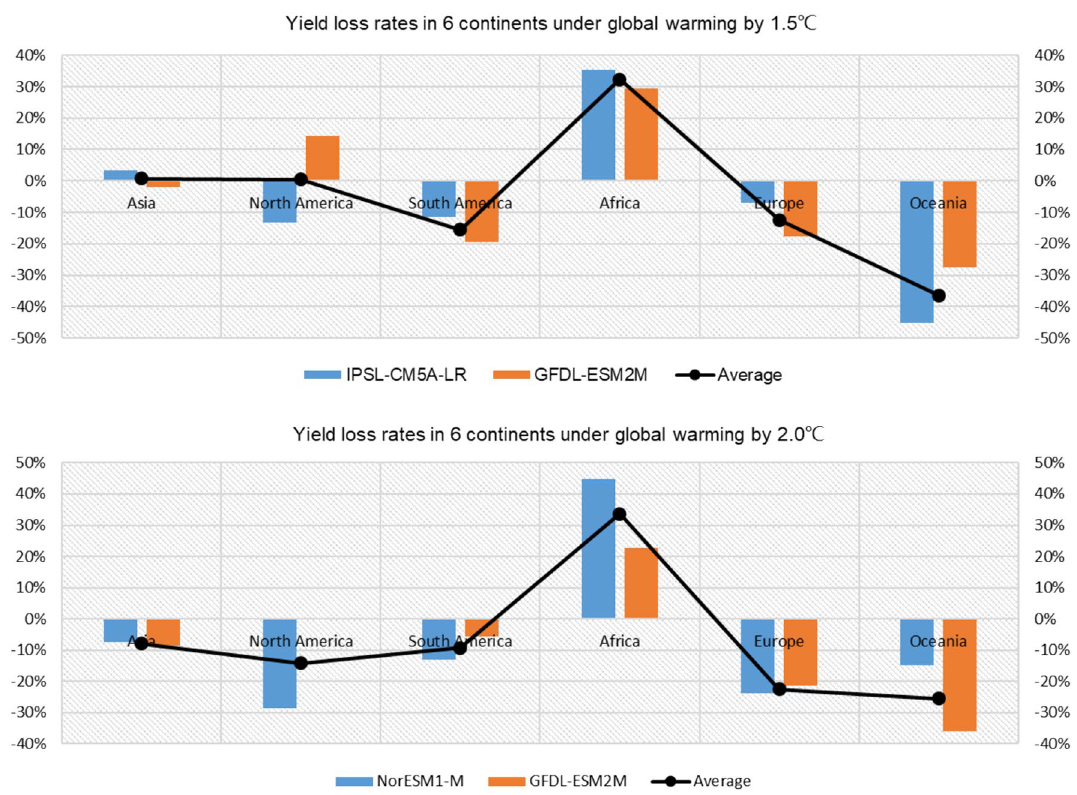
Figure 6. Yield loss rates on maize in 6 continents under global warming by 1.5 °C and 2.0